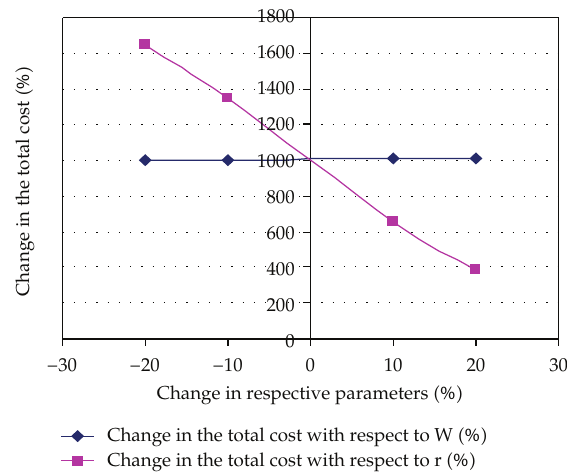
Figure 6: Percentage change in the total cost with respect to the parameters W and r .